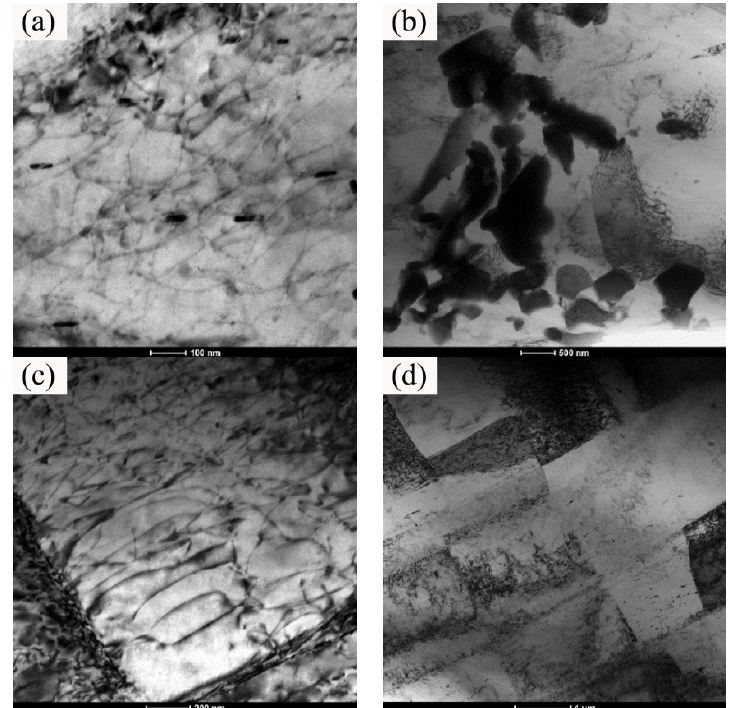
Figure 19. TEM bright field images of Mg-1YL isothermal forged at 380 ◦ C: ( a , b ) Second phases and the dislocations, ( c , d ) dense dislocations with tangles and